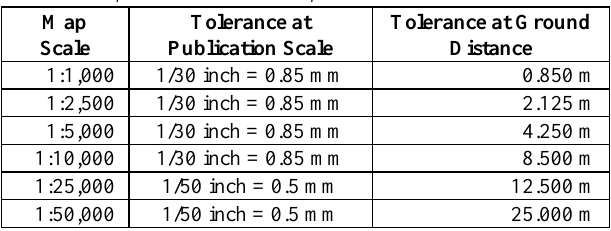
Table 5. NMAS Horizontal Accuracy Tolerance